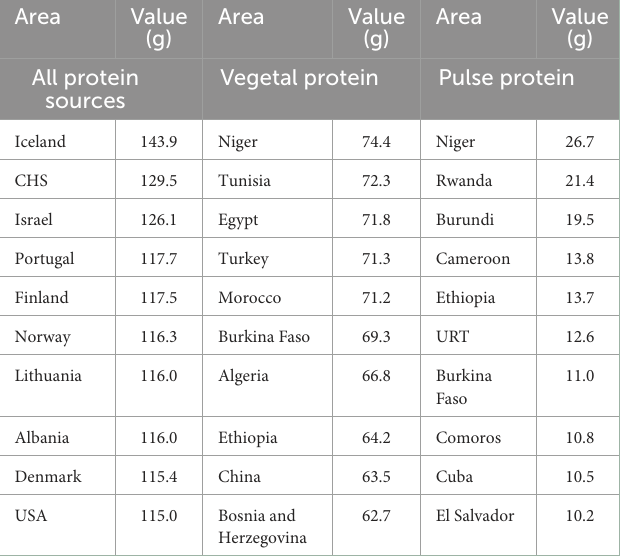
TABLE 3 Top ten per capita daily protein supplier countries through all sources, vegetal, and pulses (FAOSTAT, 2022). Area Value Area Value (g)